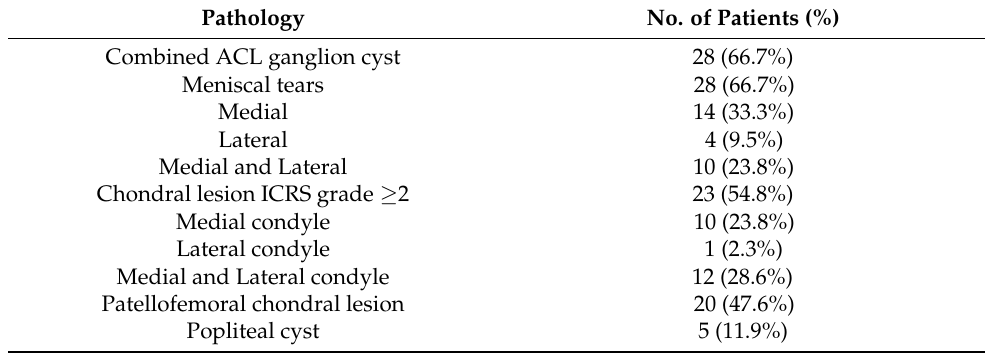
Table 2. Combined intra-articular pathologies with mucoid degeneration of the anterior cruciate ligament (MD-ACL) ( n = 42).